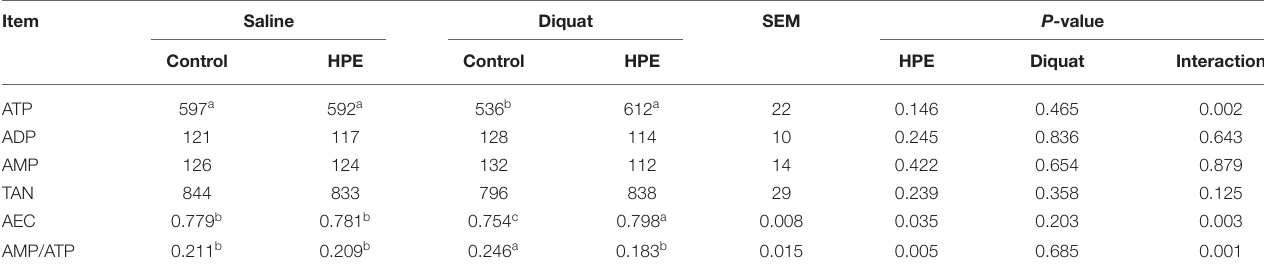
TABLE 3 | The liver ATP, AMP, and ADP contents ( µ g/g wet wt) of the piglets fed holly polyphenols extracts (HPE) diet with diquat challenge. Item Saline Diquat